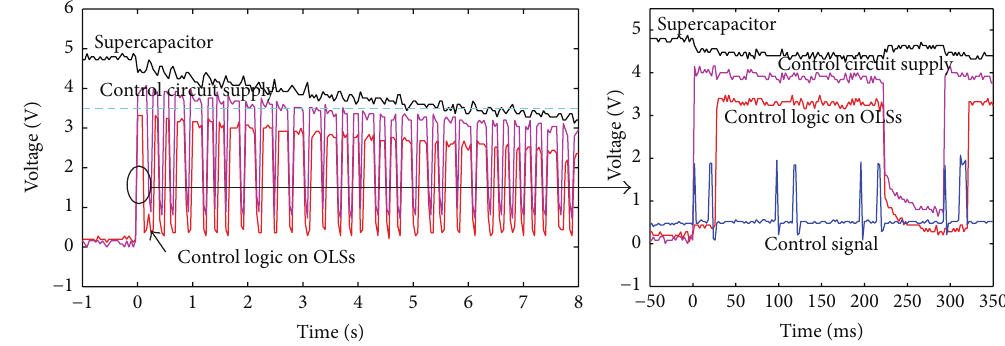
Figure 11: Discharging of the SC with the control circuit and OLS load.